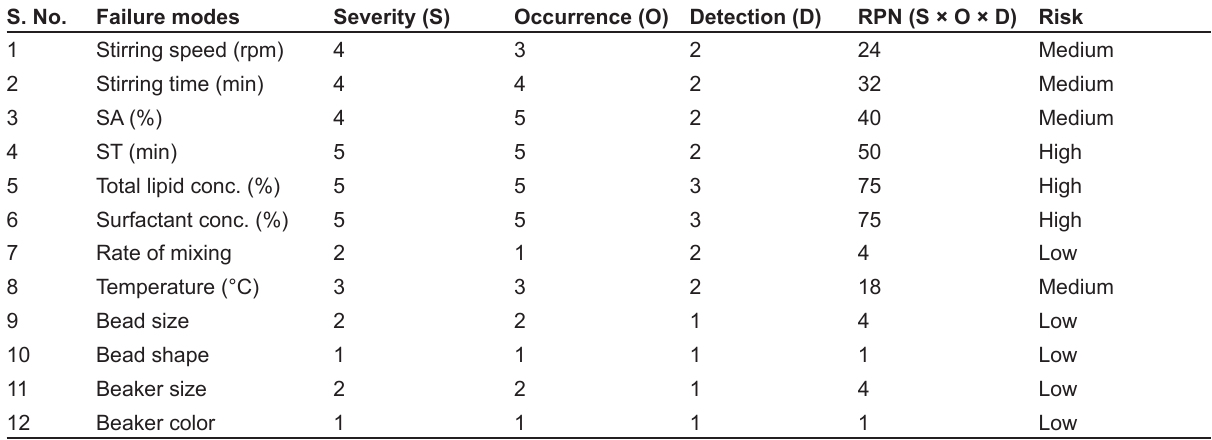
Table 3. FMEA matrix to identify the criticality of failure modes on the basis of RPN scores S.